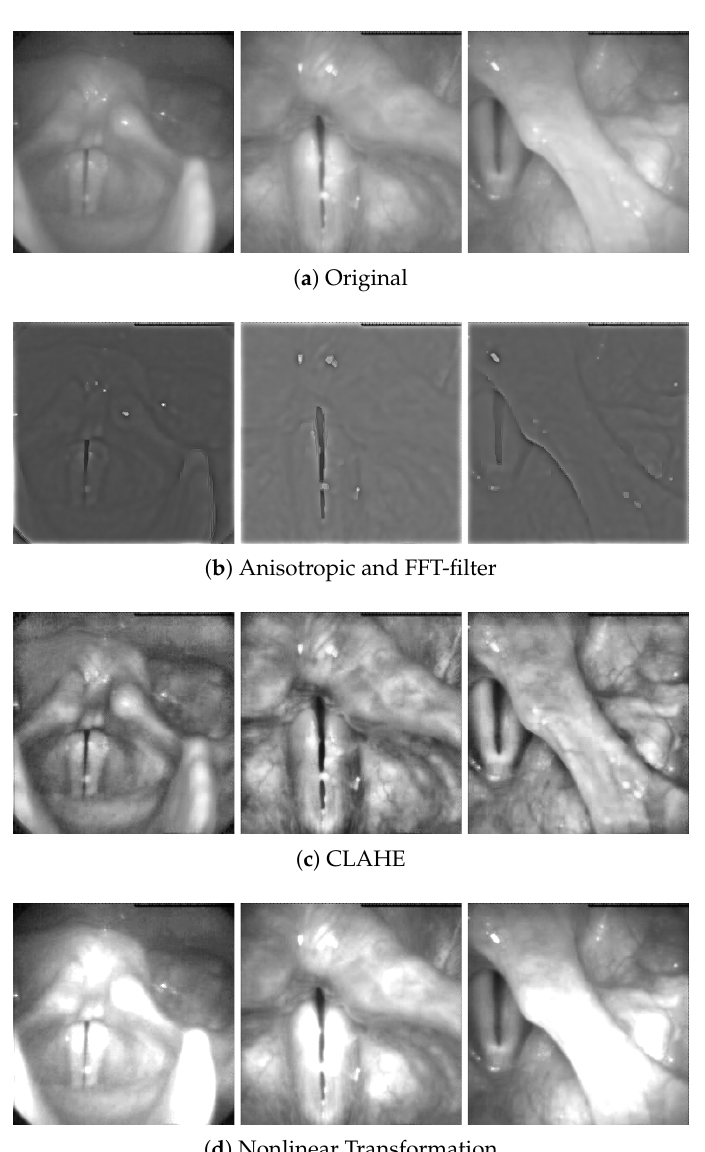
Figure 7. Visual comparison between three different enhancement methods. ( a ) original images extracted from three different videos; ( b ) enhancement method based on anisotropic with FFT-filter [97]; ( c ) enhancement method based on Contrast Limited Adaptive Histogram Equalization (CLAHE) [90]; ( d ) enhancement method based on nonlinear transformation